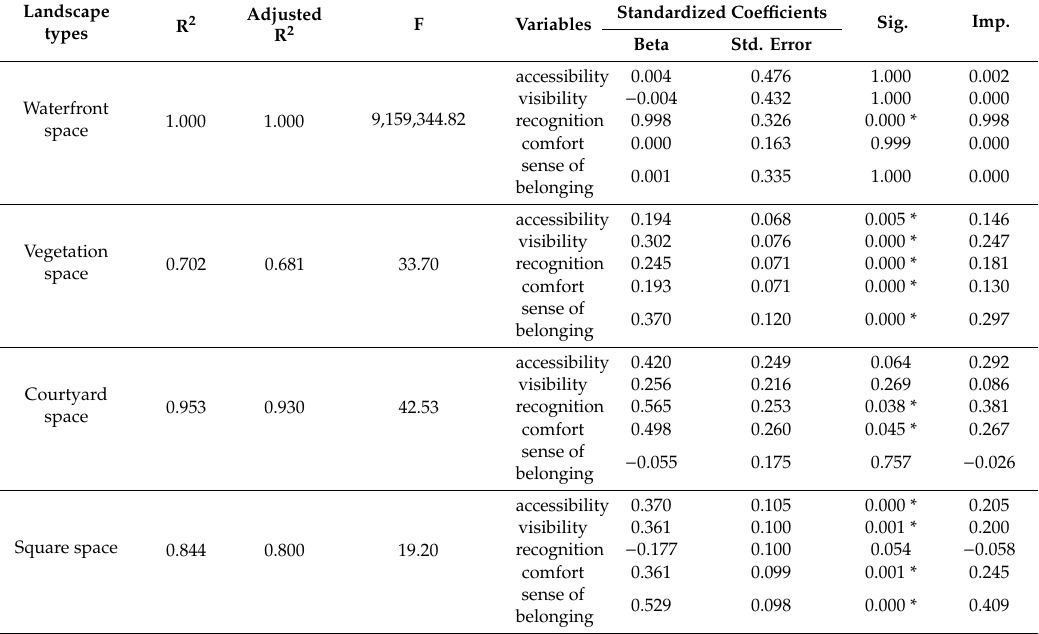
Table 4. Categorical regression (CATREG) output of four landscape types and five primary perceptual factors (n =